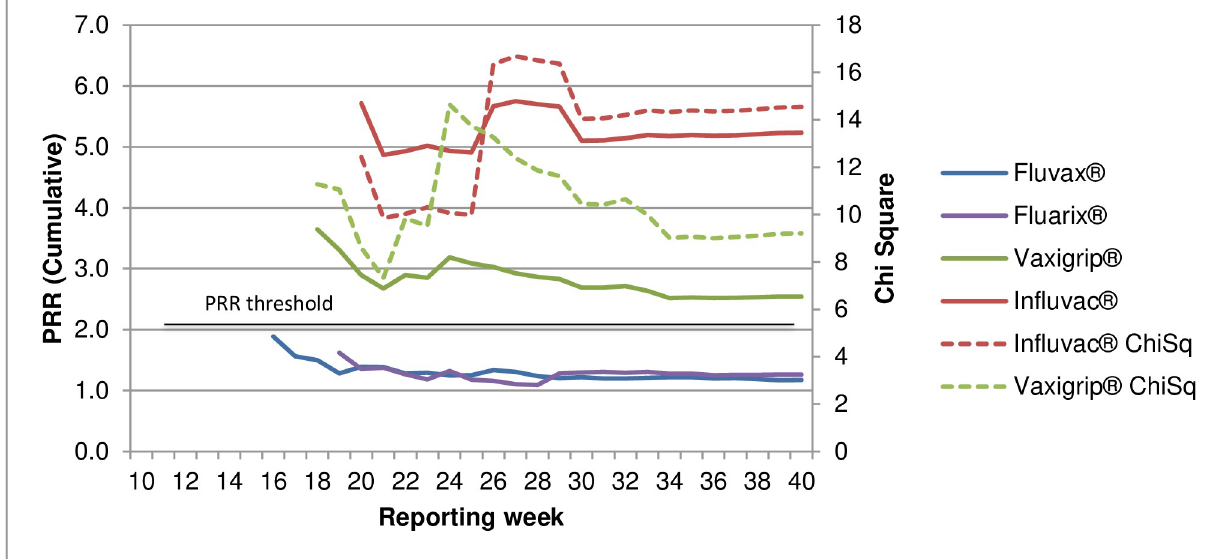
Fig 9. PRR by influenza vaccine brand to other brands, allergic AEFI, 2015.